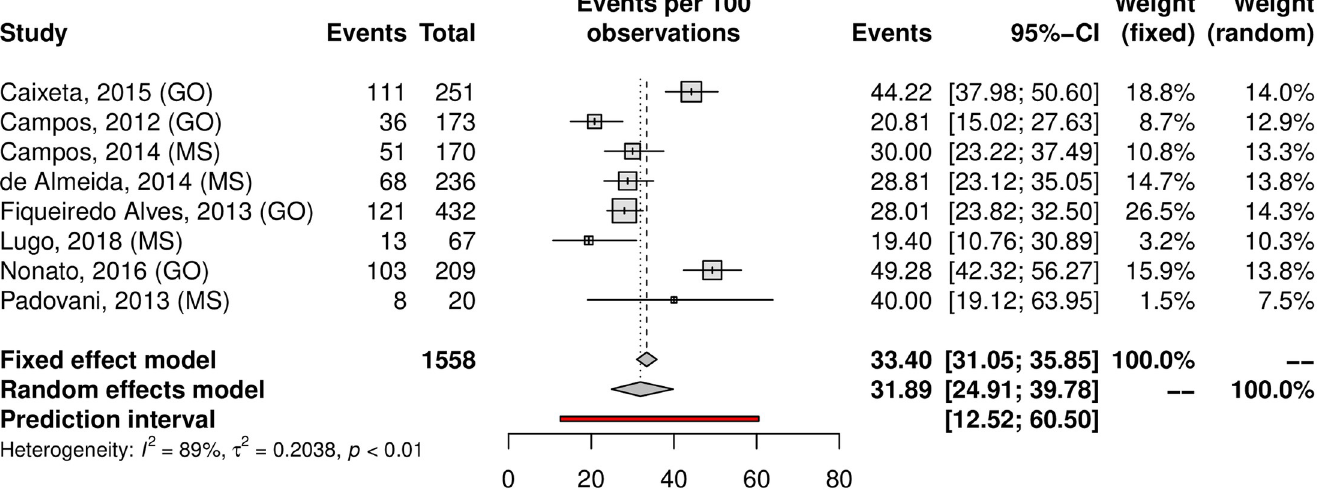
Fig 11. Prevalence of cervical HPV in the Central-West region of Brazil. Forest plot of a metanlysis of studies reporting prevalence of cervical infection by HPV in the Central-west region of Brazil.